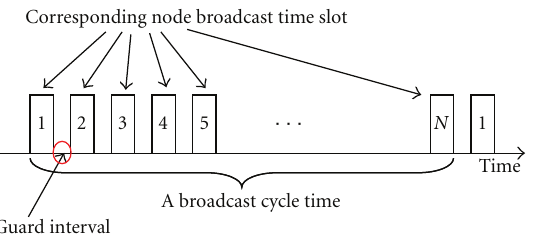
Figure 7: TDMA sending sequence.